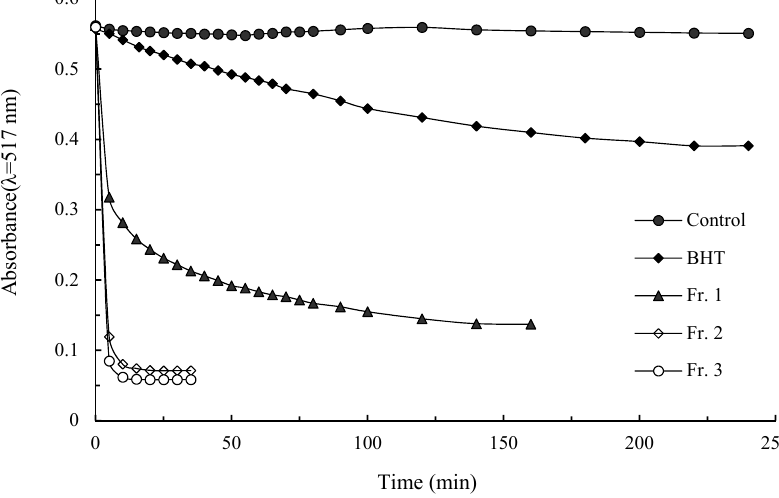
Figure 3. Contact time dependent DPPH· scavenging effects of pigment fractions from chestnut shell.